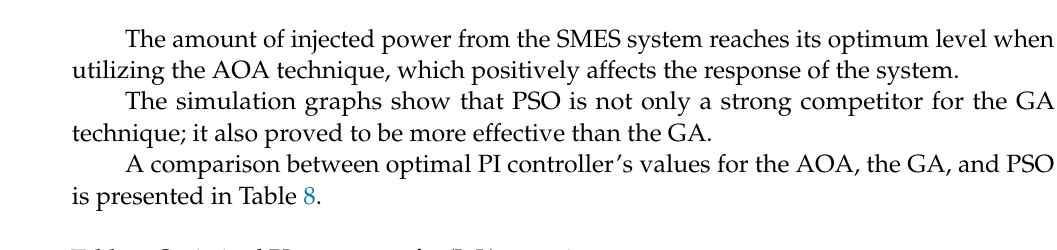
Figure 12. Simulation curves for L ‐ L ‐ G fault using the AOA, the GA, and PSO: ( a ) terminal voltage; ( b ) P curve; ( c ) Q curve; ( d ) DC link voltage curve; ( e ) SMES ‐ injected active power; ( f ) SMES ‐ injected reactive power.